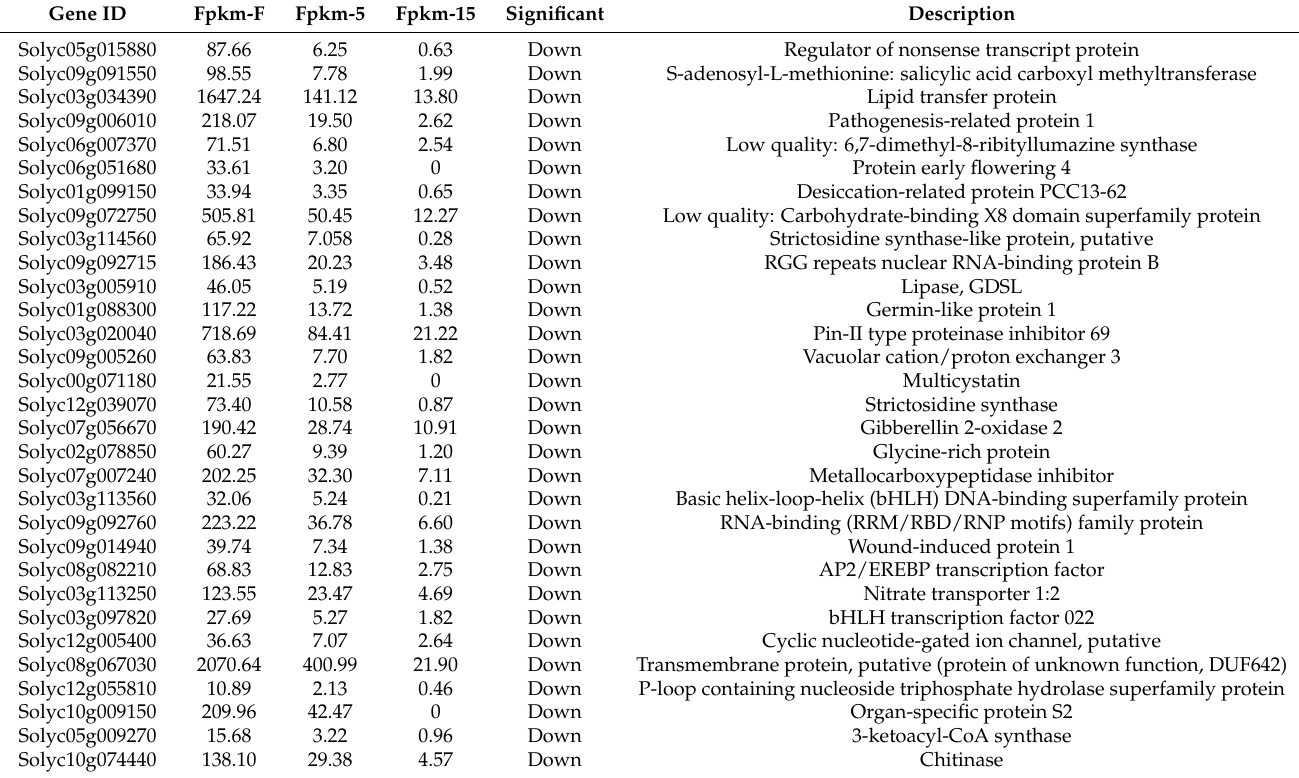
Table 2. The 31 significantly down-regulated genes under all three